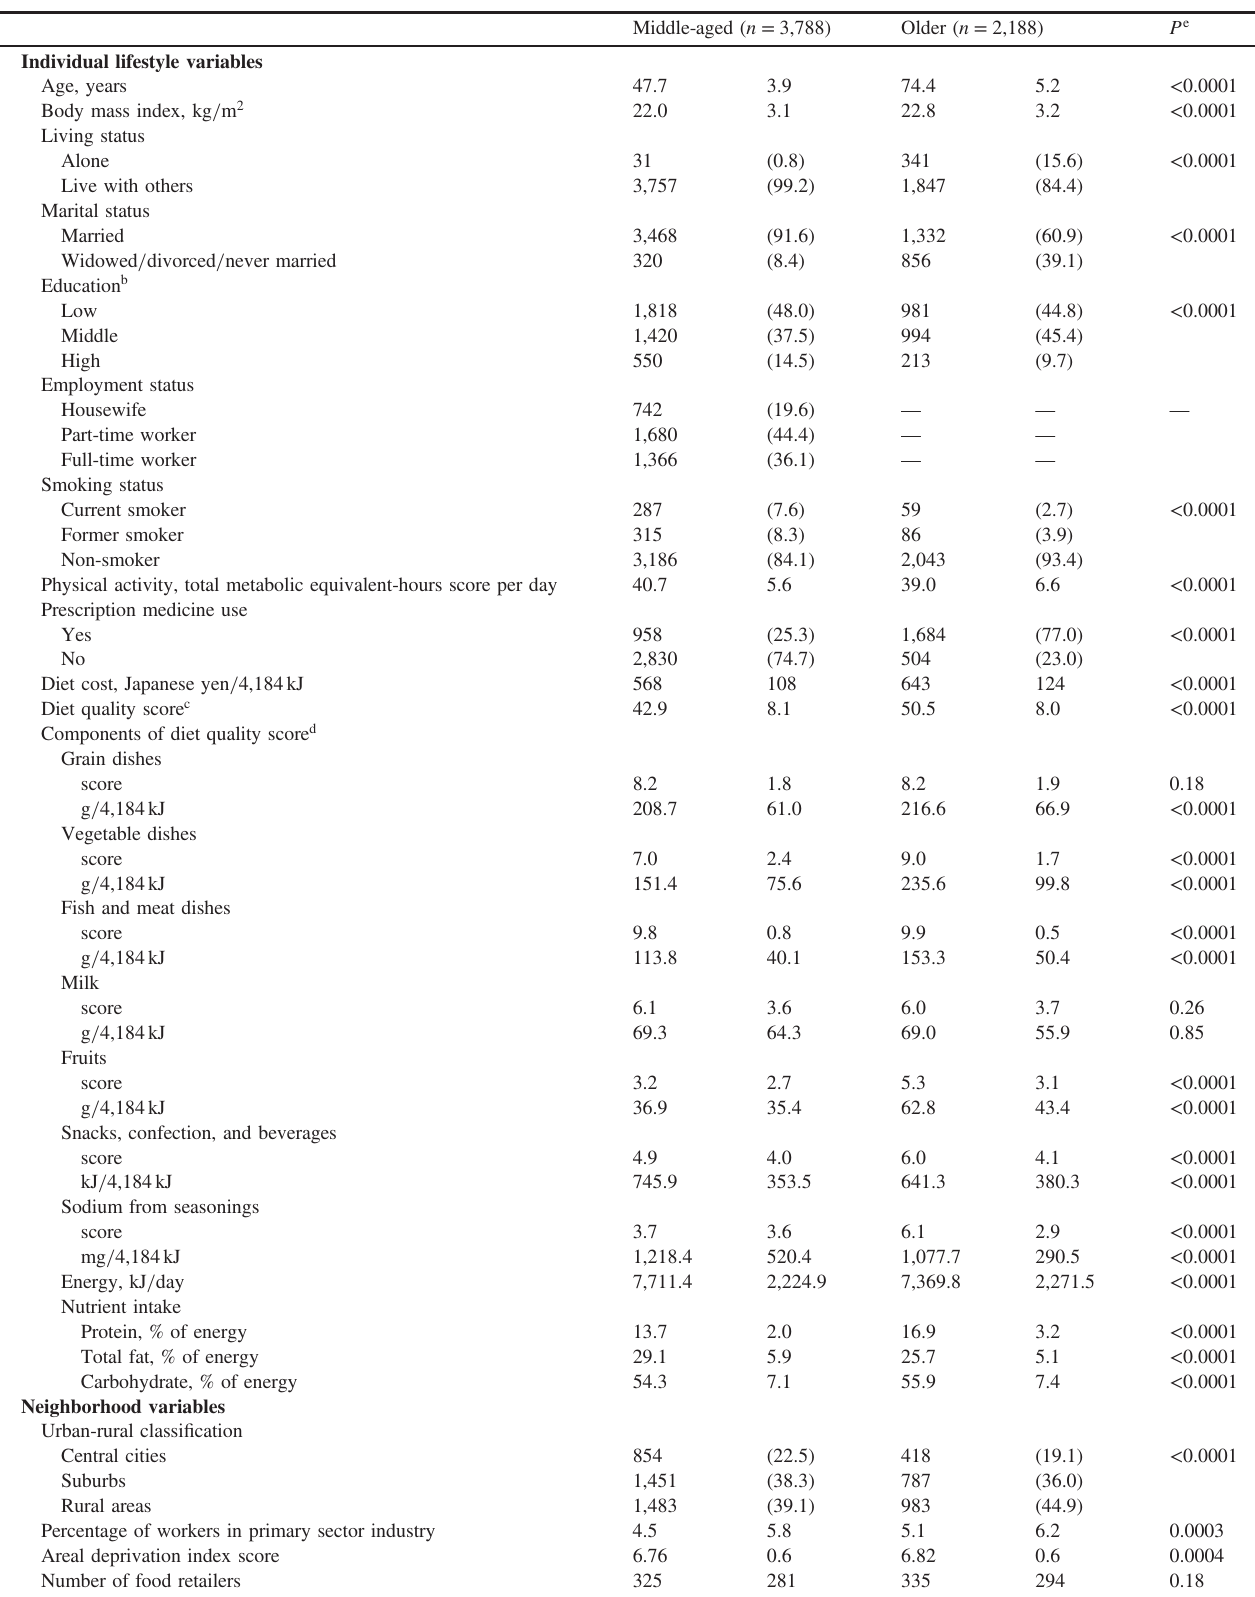
Table 1. Characteristics of middle-aged and older Japanese women